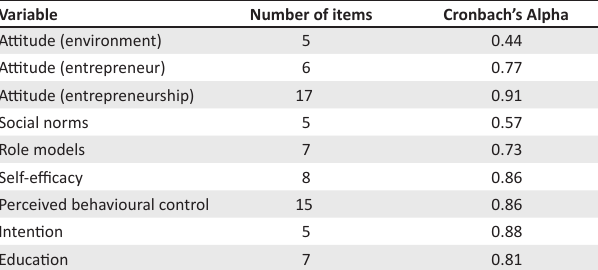
TABLE 5: Reliability statistics for the variables. Variable